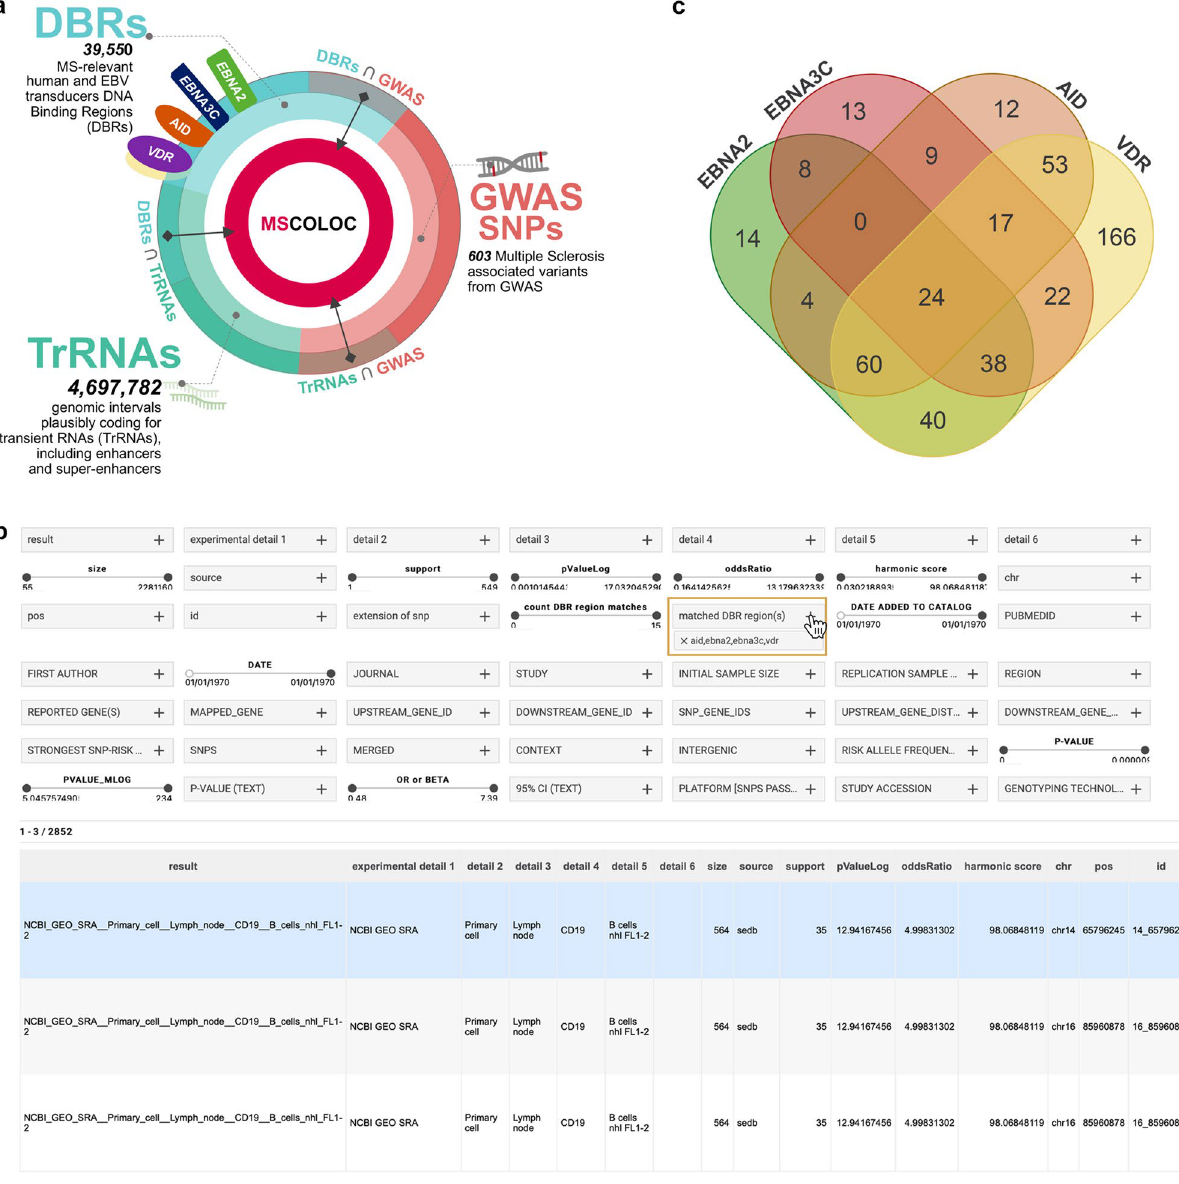
Figure 3. A comprehensive genomic atlas on gene-environment interactions regulating transcription in MS. ( a ) Searchable results at mscoloc.com derive from the matches of GWAS MS regions, DNA binding regions of selected genomic transducers, and more than 4 million of regions annotated as plausible transient RNAs. ( b ) The user interface includes text panels and range sliders allowing extremely personalized queries, that combine statistical significance level (including Odd Ratio, p Value, support, and Harmonic Score), study source, SNP or reported gene, and so on. Filtered results are shown as tables ranked by HS, that can be saved, printed or shared through URL. In the example, the cursor selects ‘ AID, EBNA2, EBNA3C, VDR’ in the ‘ matched DBR region (s)’ panel looking for MS-associated SNPs (from the ROI, Additional File: Table S1) and their extensions at ± 50, 100, 200 kb that colocalized within DNA binding regions of the molecular transducers. The top hit represents the colocalization of the DBRs, a super-enhancer region derived from experiments on CD19 + B cells included in sedb, and the rs8007846 MS-associated SNP on chromosome 14. ( c ) The Venn diagram shows the number of non-redundant MS-associated SNPs derived from the query: for each transducer, SNPs are considered only once if present in more than one match. Intersections show the numbers of regions colocalizing with DBRs of multiple transducers. For instance: 8 regions colocalize with both EBNA2 and EBNA3C DBRs, but not with AID nor VDR DBRs; 24 regions colocalize with all four DBRs, and could be identified as regulatory “hotspots” in